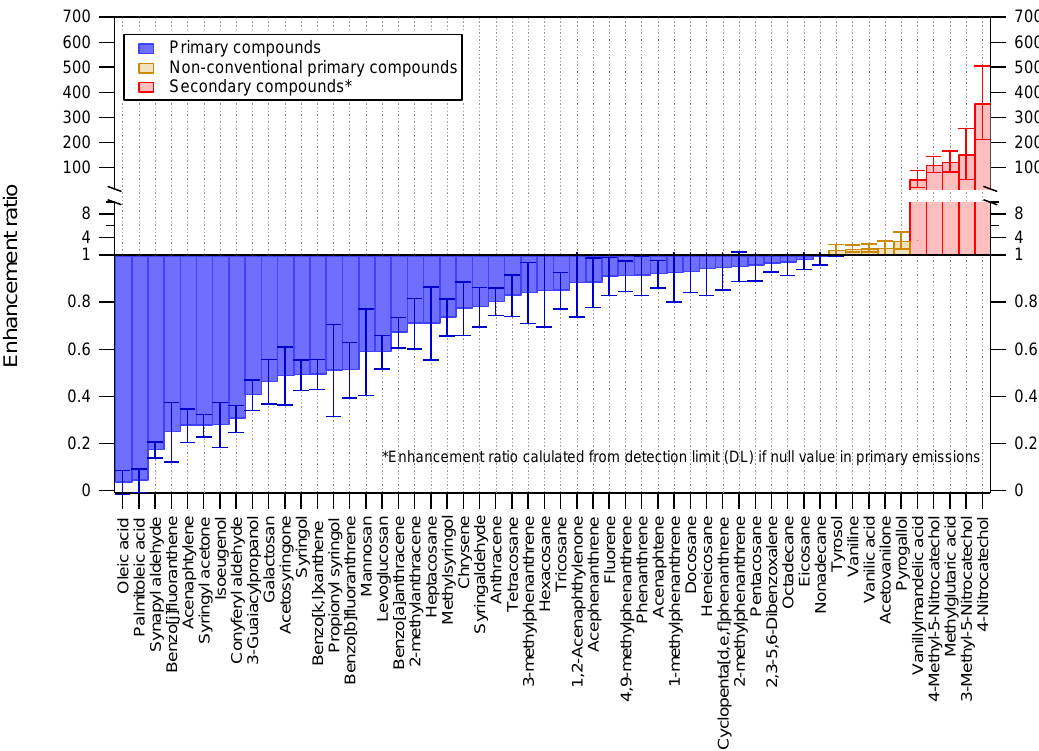
Figure 7. Mean enhancement ratios (ERs) of individual compounds in biomass burning emissions. The ER is defined as the pWLC concen- tration measured in the particle phase within a time range corresponding to an integrated OH exposure of 4–6 × 10 6 moleculescm − 3 h (bin 4, Fig. 6) and divided by the concentration in the particle phase measured at t 0 (i.e., before lights on). An ER of 0.8 means a loss of 20% during aging after pWLC. Note that for the secondary compounds (red) observed after the start of the photo-oxidative process only, the ERs are calculated using the detection limit. Error bars show the standard deviation derived from all